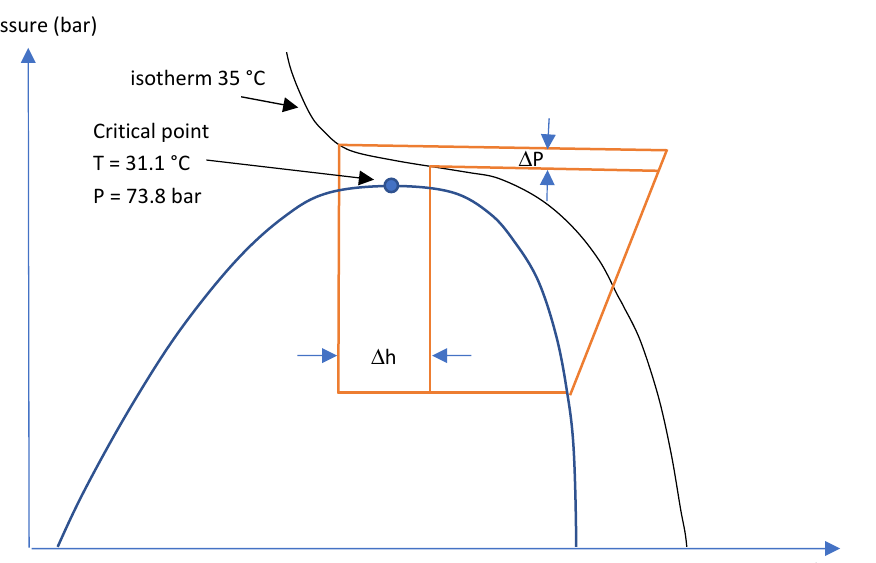
Figure 5. CO 2 transcritical cycle on the P-h diagram.